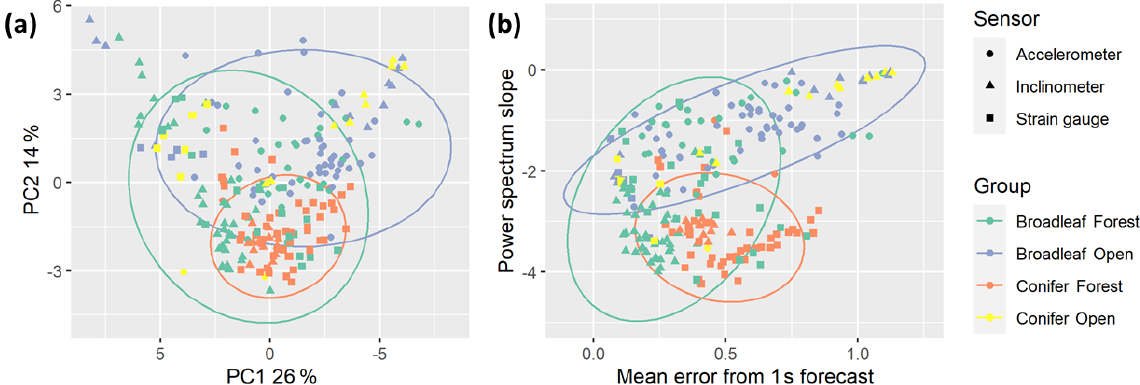
Figure 3. Features of tree motion from 229 trees during summer high (local) wind speed conditions projected on (a) first two principal component axes (arbitrary units) and (b) maximally discriminant axes (original units, unscaled). Ellipses represent Student’s t distributions around the data and were only drawn around groups with sufficient samples: broadleaf forest ( N = 86), conifer forest ( N = 63), and broadleaf open ( N =